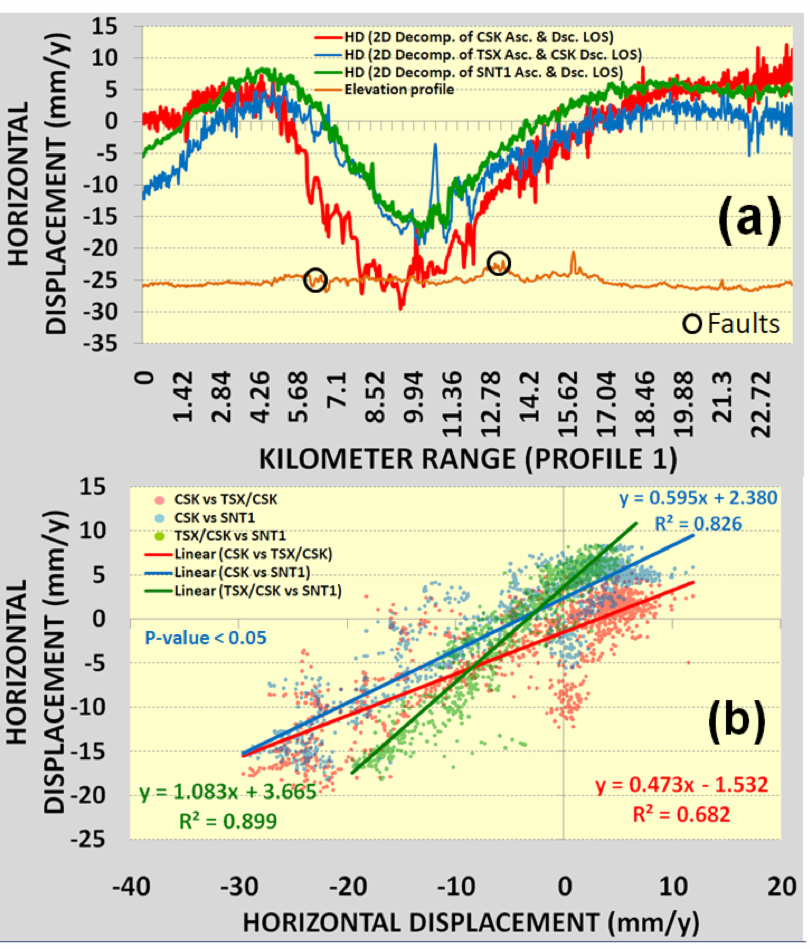
Figure 15. Horizontal displacement velocity: ( a ) profile; ( b ) regression for profile.